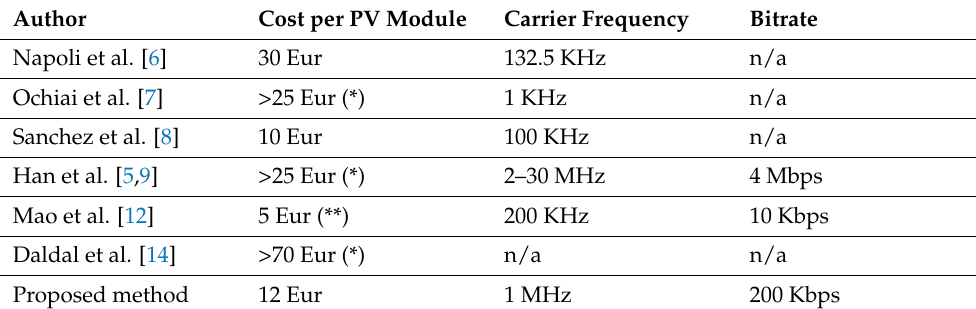
Table 2. Comparison of the different PV PLC systems found in the literature with ours regarding the cost and communication speed